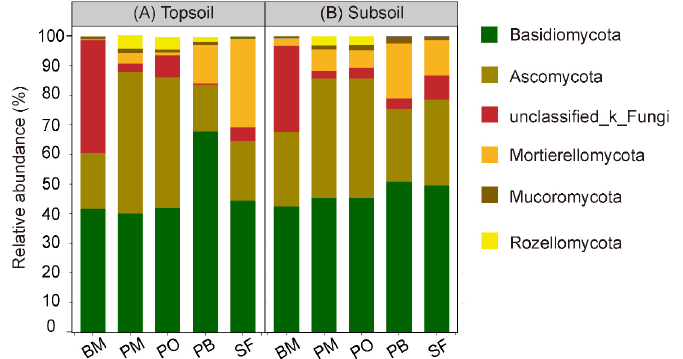
communities differed in forest types in both topsoil and subsoil (Figure 4; p = 0.001). The first axis separated the two P. massoniana monocultures from other forests.